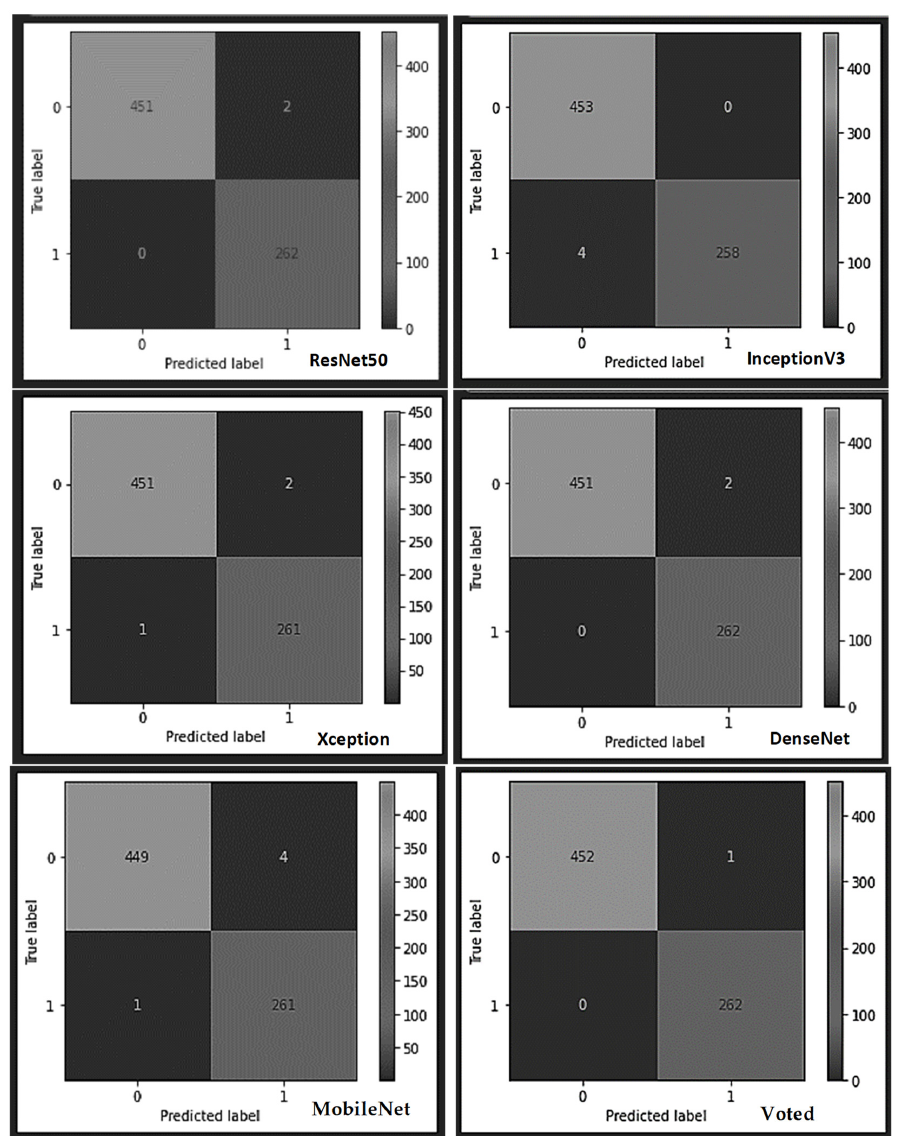
Figure 8. The various confusion matrices obtained from each learner using the impeller casting da- taset.